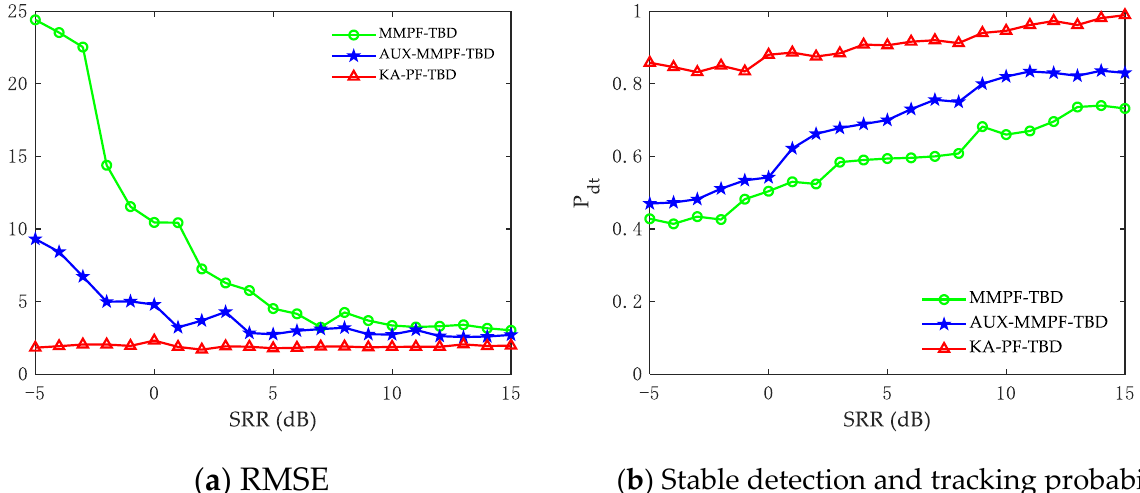
Figure 6. ( a ) The RMSE under different SRR. ( b ) The stable detection and tracking probability under different SRR.